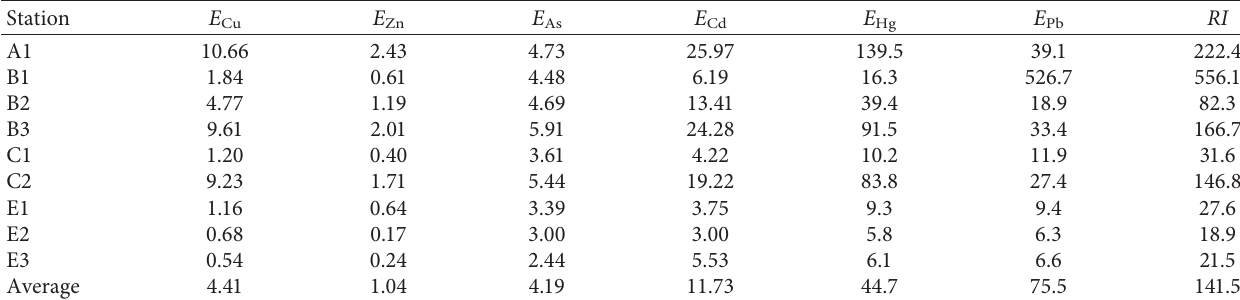
Table 10: The ecological risk index ( E i r ) and potential ecological risk index ( RI ) values for different heavy metals in sediments at all stations within Jiuzhen